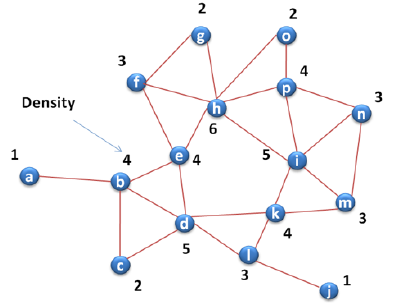
Fig. 1. Cluster head selection and Clusters formation (Nodes and their neighborhood density)